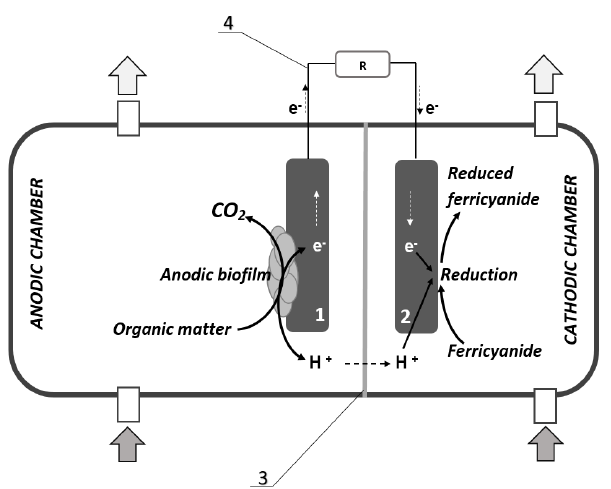
Figure 1. Typical two chamber MFC; 1—anode, 2—cathode, 3—PEM, 4—external circuit and resistor [5].